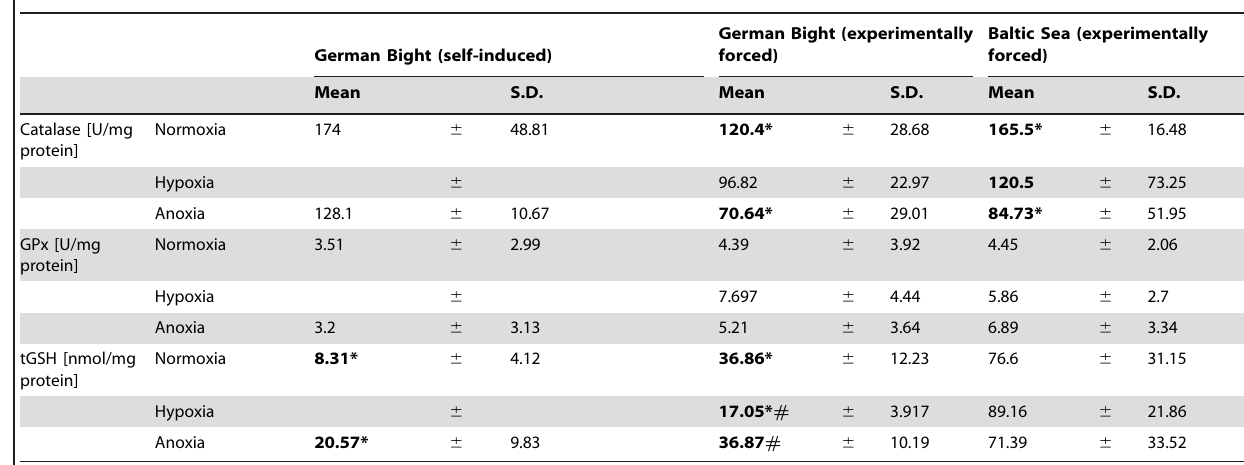
Table 4. Activities of the antioxidant enzymes catalase and glutathione peroxidase (GPx), as well as total glutathione concentrations (tGSH = GSH + GSSG) of Baltic Sea and German Bight individuals incubated (experimentally forced) under 3.5 days of Normoxia, Hypoxia or Anoxia, or after 24 h self-induced normoxia or